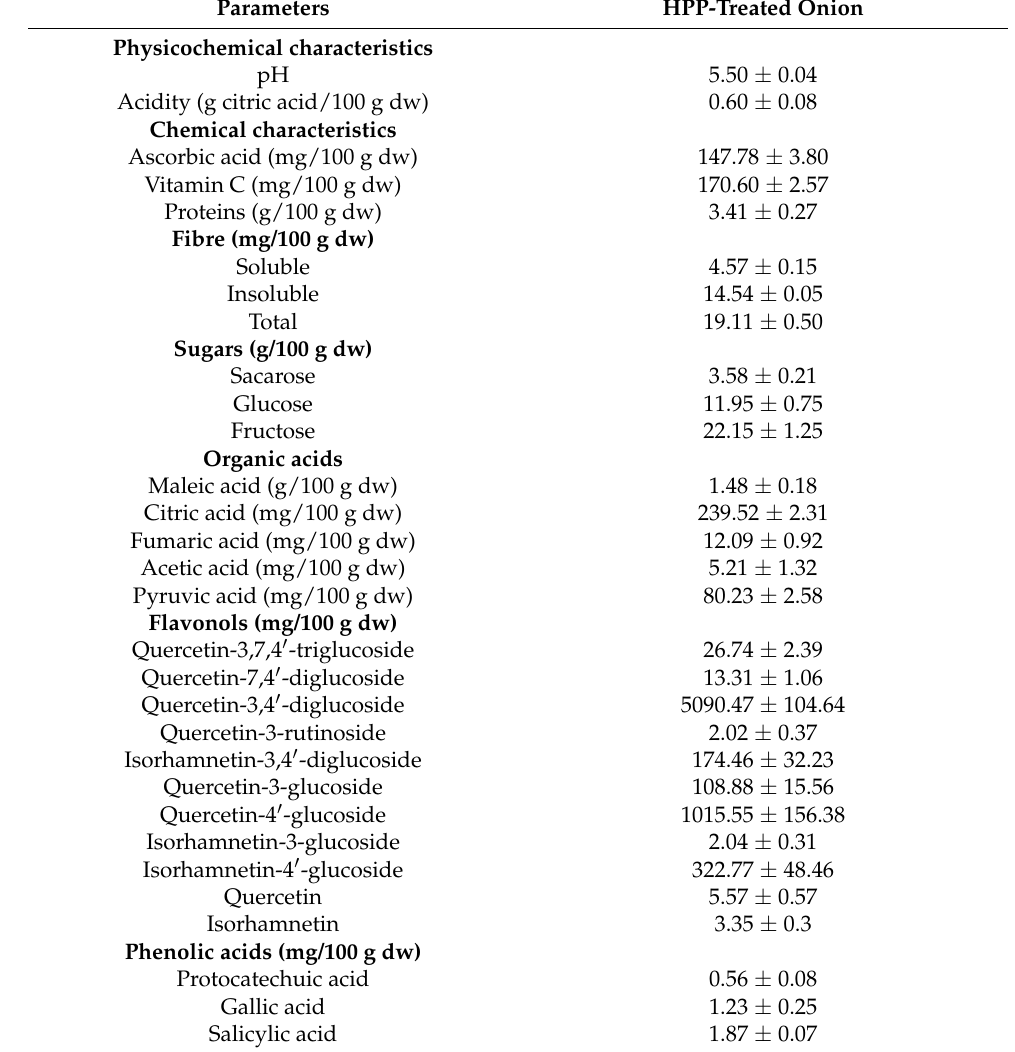
Table 1. Characterization and phenolic compound content of the HPP-treated onion